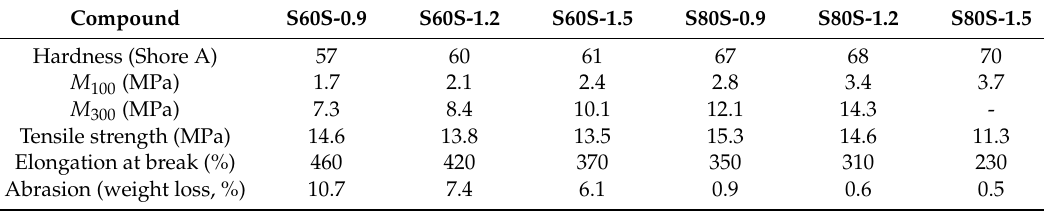
Scheme 3. Suggested mechanisms of vulcanization and silica–rubber coupling. Table 5. Mechanical properties and abrasion loss of vulcanizates by sulfur